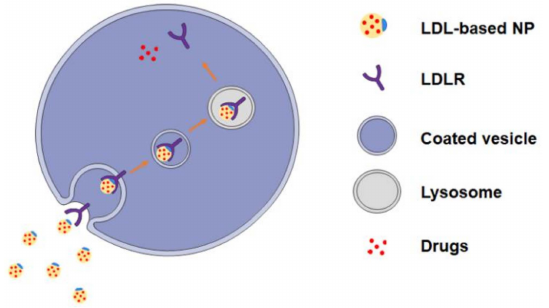
Figure 2. Schematic diagram of cellular uptake of LDL-based NPs loaded with drugs by LDLR- mediated